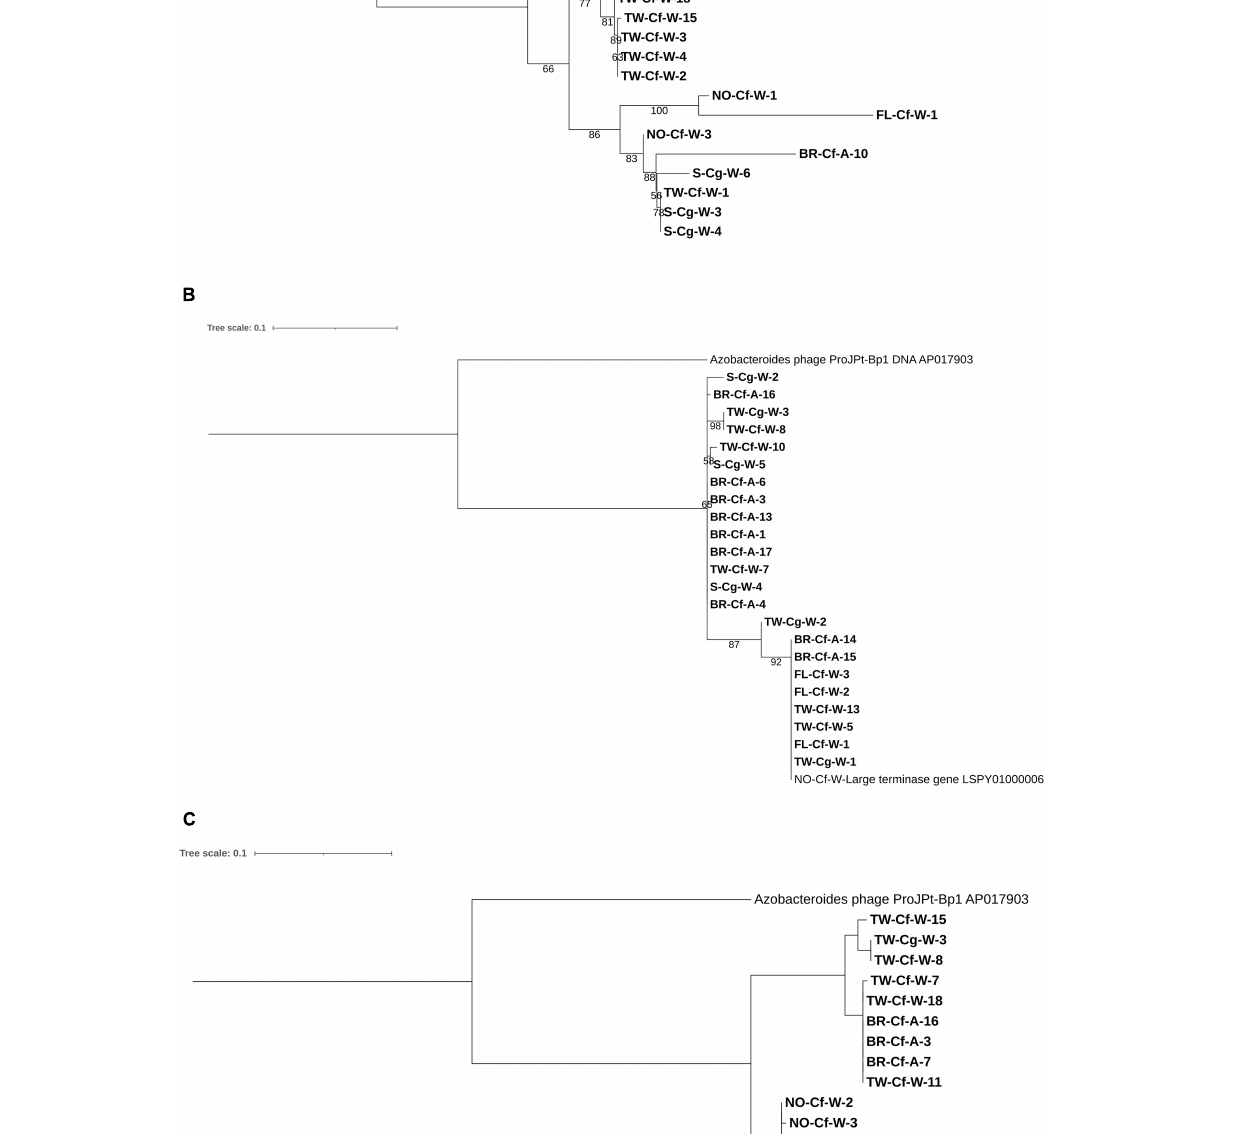
Frontiers in Ecology and Evolution |